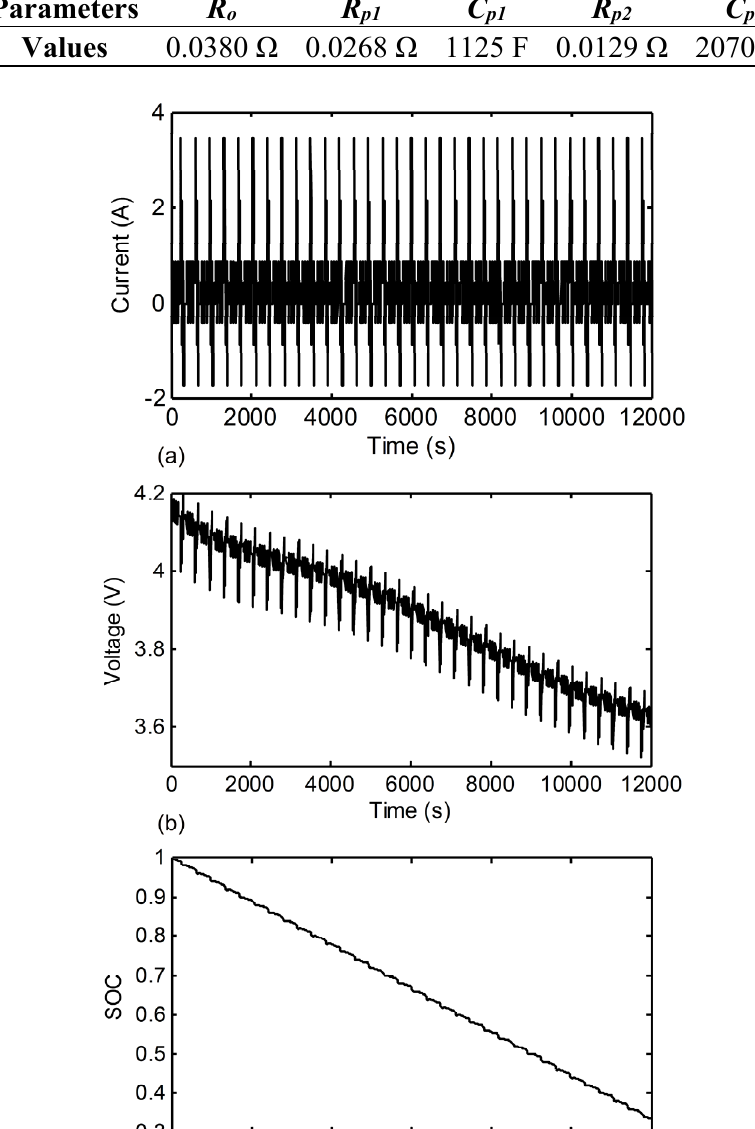
Table 1. Identified parameters of the battery model.